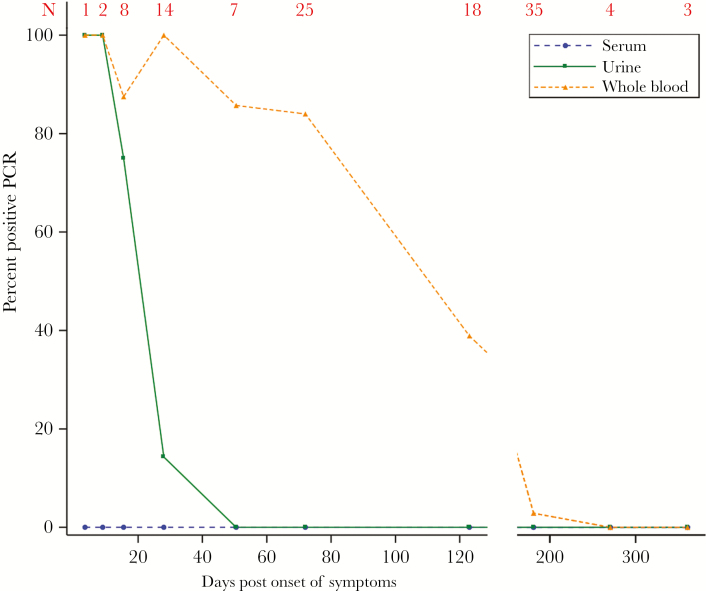
Zika virus (ZIKV) RNA persists much longer in whole blood than in either serum or urine. The 10 data points plotted for each of the 3 body fluid types shown here represent the proportions of each body fluid with positive ZIKV RNA detection within each time interval. The 10 time intervals were days post onset 1–6, 7–11, 12–19, 20–36, 37–64, 65–79, 80–166, 167–195, 196–345, and 346–375. The total numbers of whole blood, urine, and serum samples assessed during each interval are provided in red at the top of the figure.